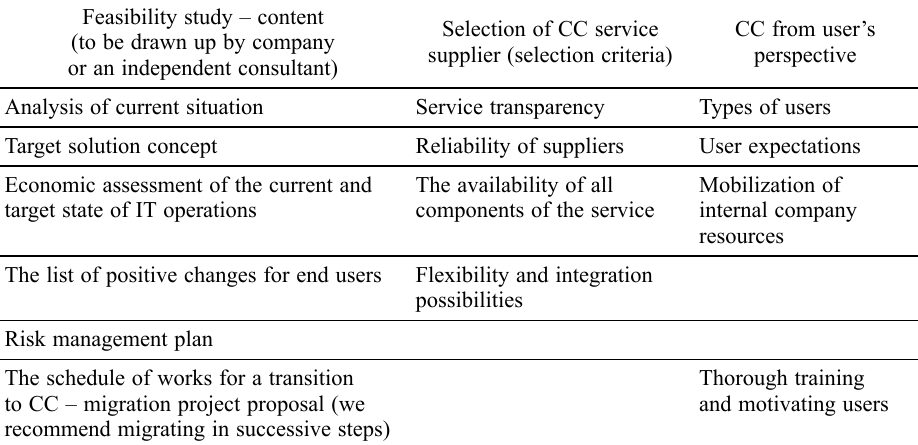
Table 5. Transition of IT companies to cloud